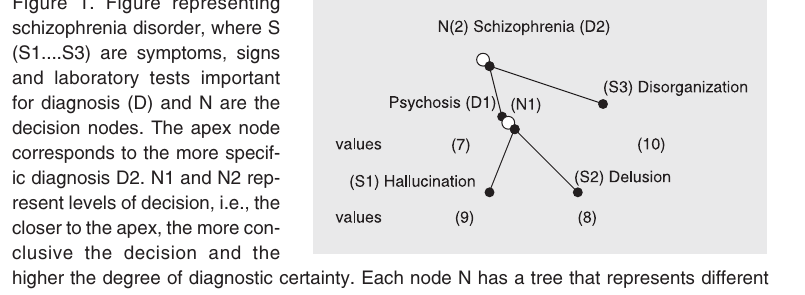
for diagnosis (D) and N are the decision nodes. The apex node corresponds to the more specif- ic diagnosis D2. N1 and N2 rep- resent levels of decision, i.e., the closer to the apex, the more con- clusive the decision and the higher the degree of diagnostic certainty. Each node N has a tree that represents different combinations of symptoms. Values of 0 to 10 were attributed to each symptom according to its specificity (0 = totally unspecific for diagnosis of schizophrenia disorder and 10 = very specific for diagnosis of schizophrenia